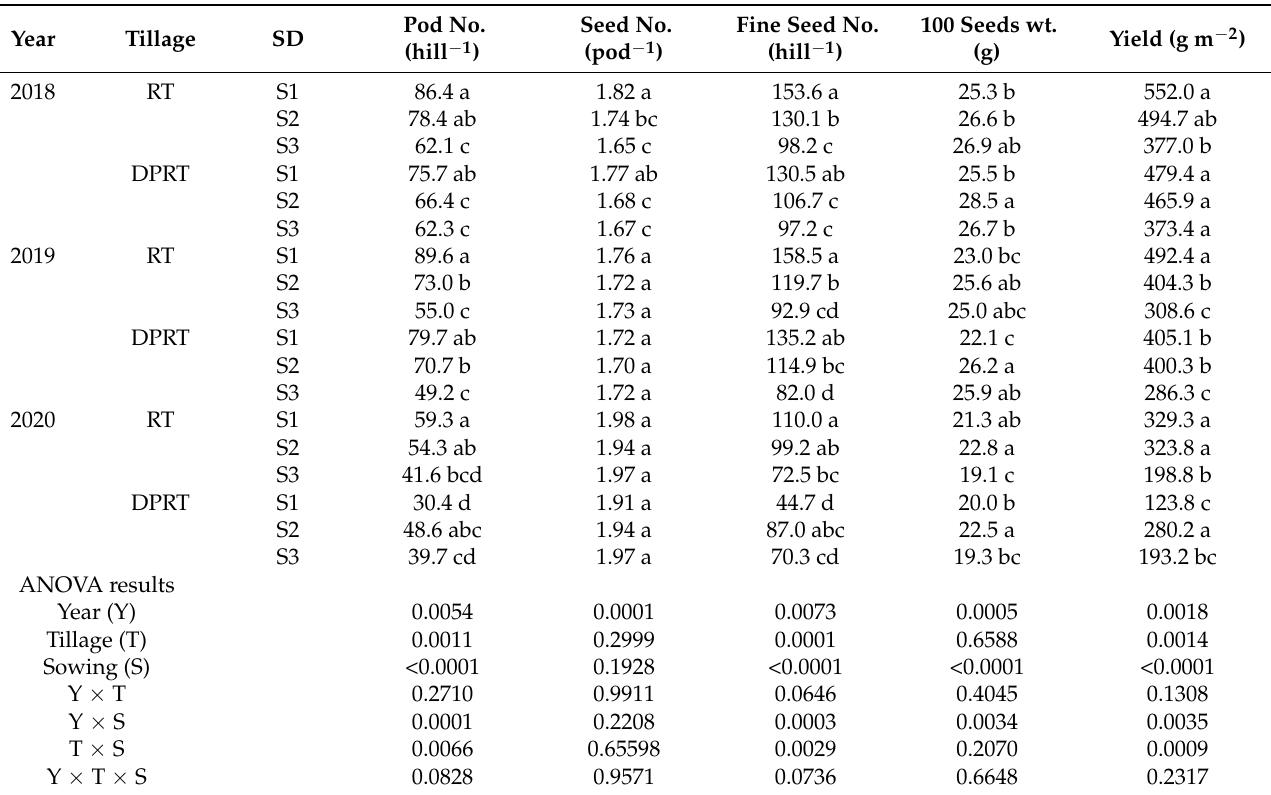
Table 4. Yield and its key components of double-crop soybeans grown in drained paddy fields under different tillage systems and sowing dates over three seasons (2018–2020). ANOVA (analysis of variance) results ( p -values) are given for each parameter.